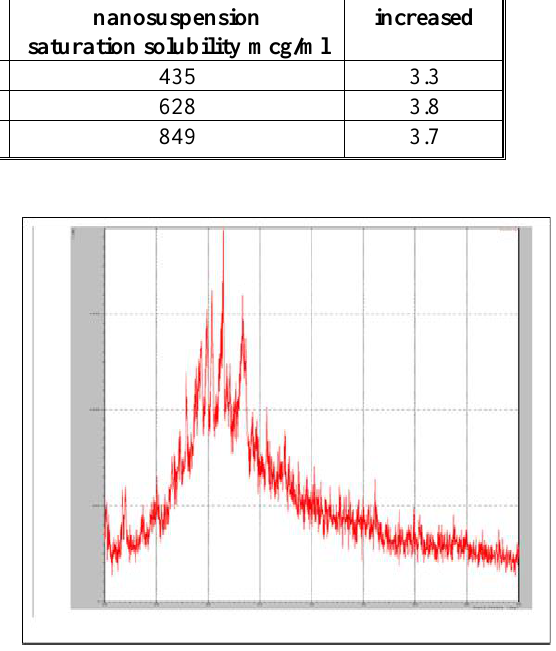
Figure 11. XRD highest intensity peaks of atorvastatin calcium nanosuspension. DSC thermogram of atorvasatin calcium nanosuspension reported in figure 12(A and B). The thermogram represented a specific dropping peak at 159.96  C, which is very close to the melting point of pure atorvastatin calcium powder that reported to be 165.5  C on electrical melting point instrument (23) .